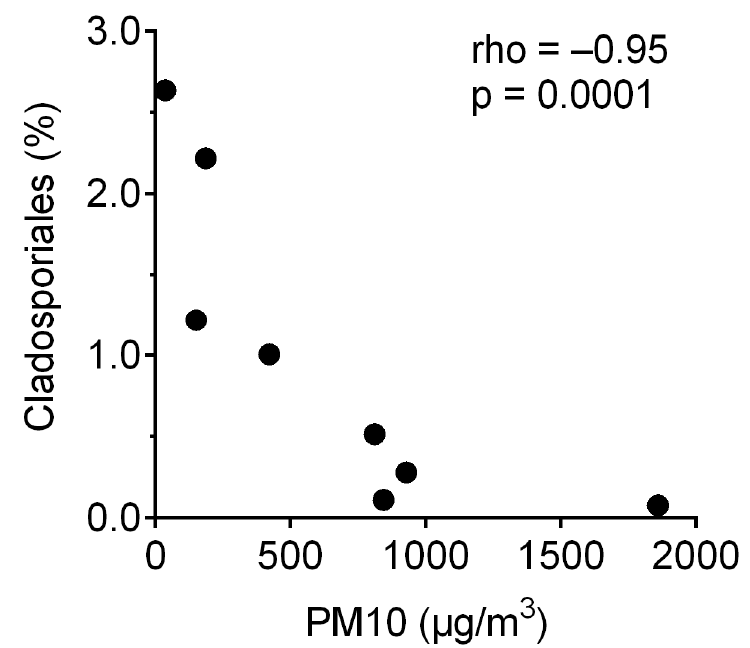
Figure 6. Percentage of reads from each metagenome that mapped to the fungal MAG reconstructed in this study.